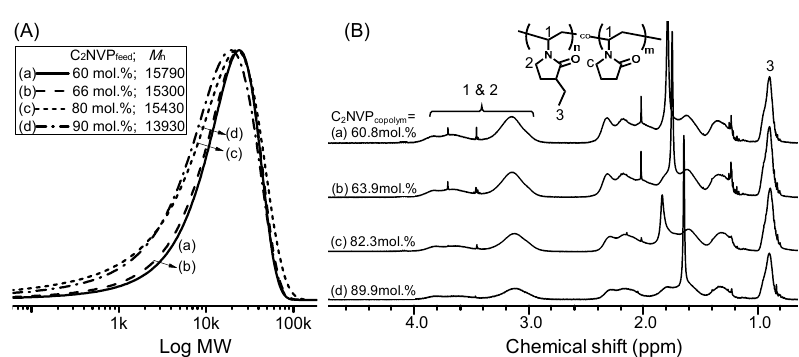
Figure 3. Kinetic C3–C6 copolymers of ( A ) GPC traces and ( B ) 1 H NMR spectra (400 MHz, CDCl 3 ) through RAFT copolymerization different monomer feed ratios (C 2 NVP feed = 60, 66, 80, and 90 mol %; M/MHEX/AIBN = 200/1/0.1 in EtOH at 70 ◦ C).